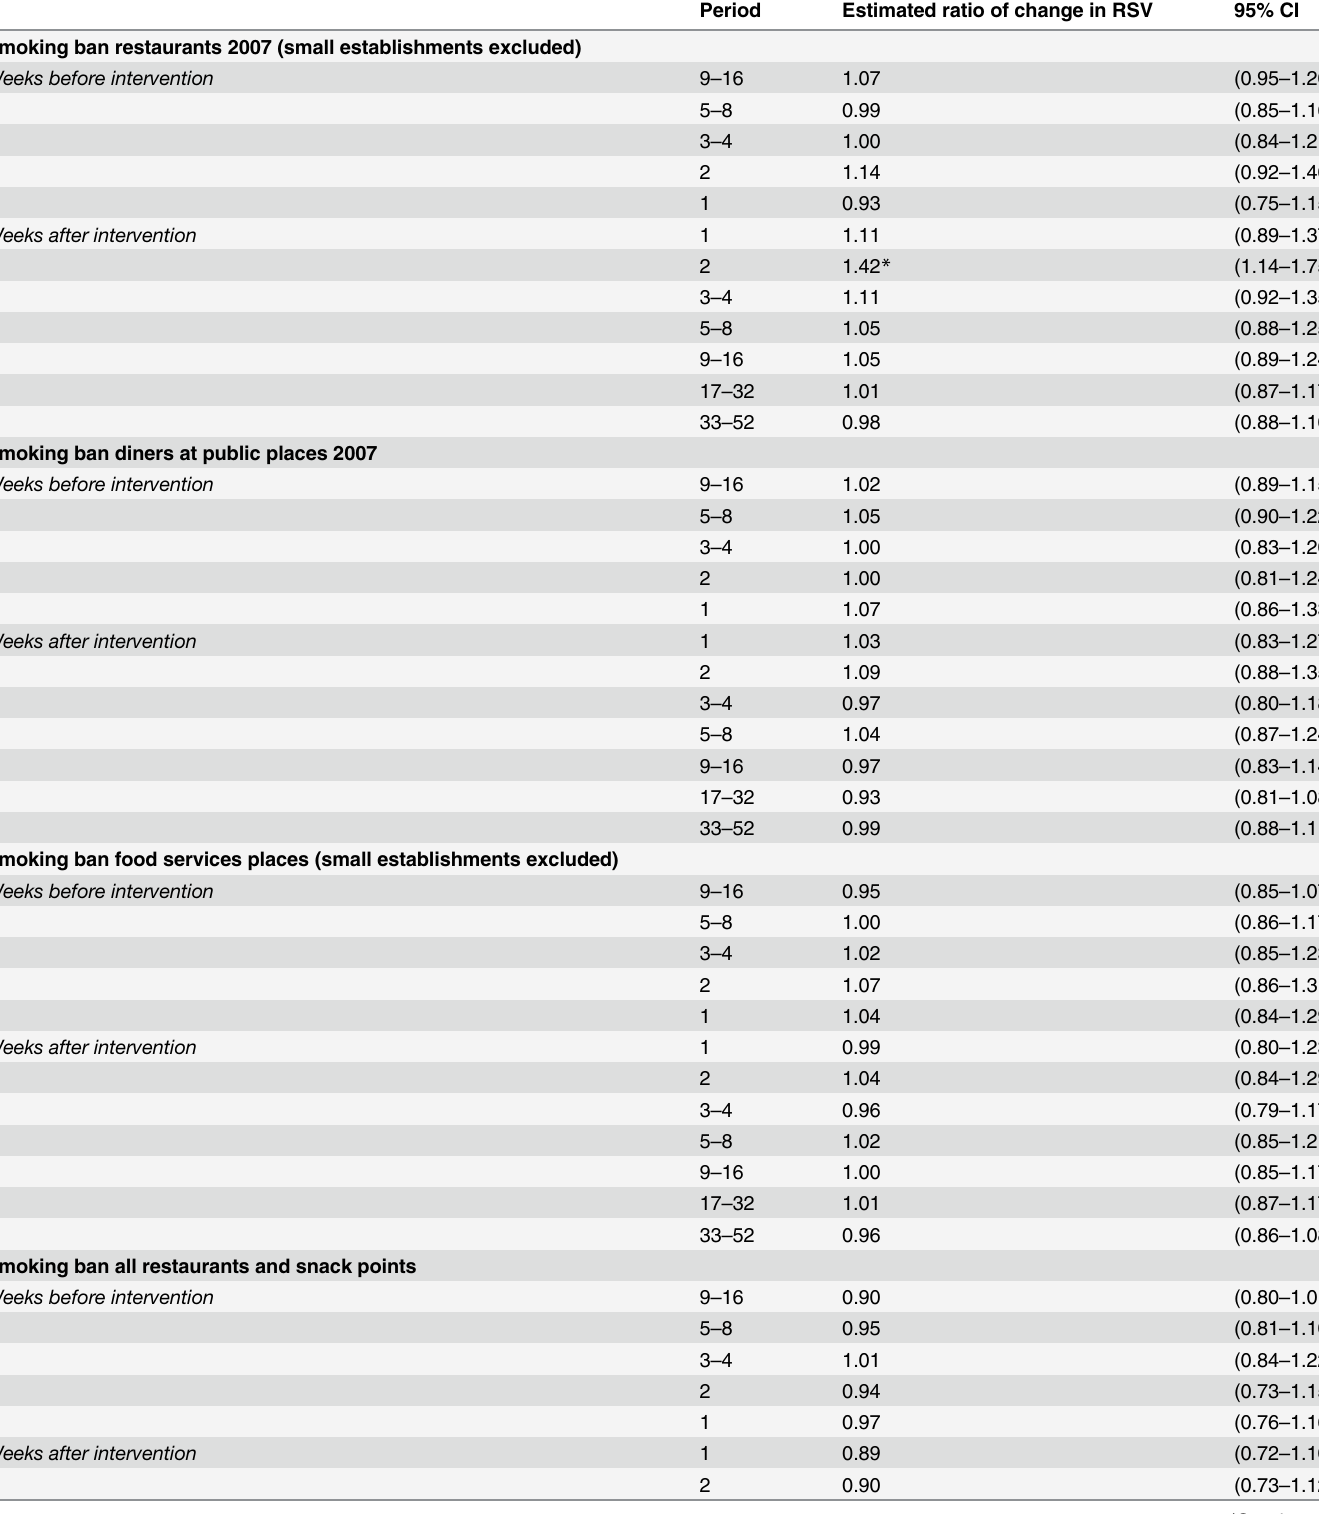
Table 2. ARIMA modelling outcomes for Belgian smoking cessation policies of Belgian RSV